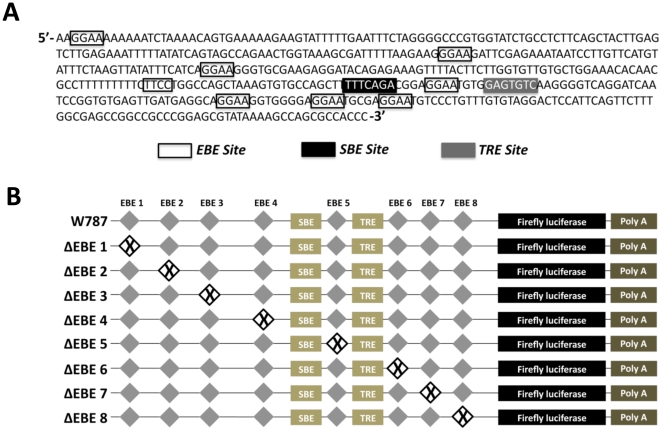
Identification of putative Ets-1 sites in the CCN2 promoter.(A) The CCN2 proximal promoter (pictured are bases −293 to +1) contains eight putative Ets-1 binding sites (EBE 1–8) (open boxes), and these sites are in close proximity to the TRE (grey box) and SBE (black box). (B) Multiple mutation constructs were created containing individual substitutions of the EBE at positions 1–8 (ΔEBE 1–8) in the CCN2 proximal promoter that was cloned into a pGL3-firefly luciferase reporter construct.